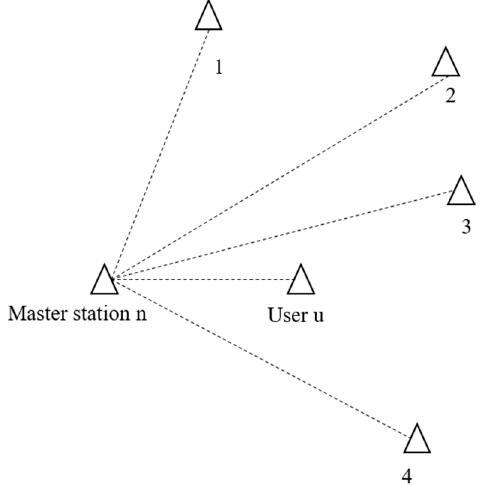
Figure 2. Network real-time kinematic (RTK) principle.